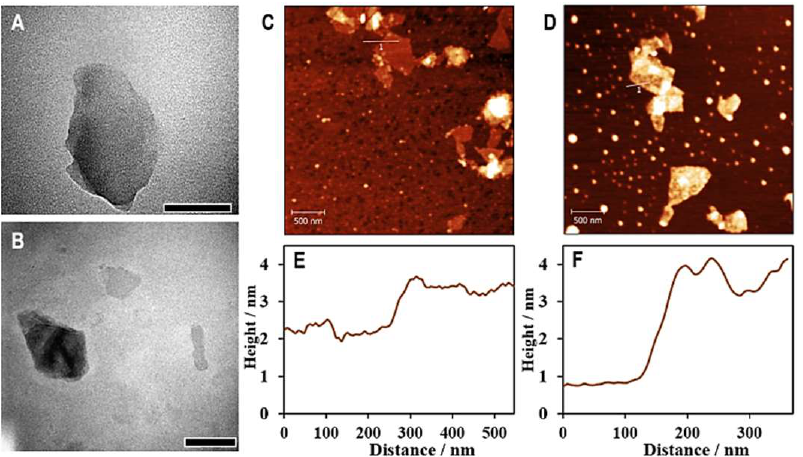
Figure 2. TEM and AFM analysis of GO and HGNs. TEM images of graphene oxide nanosheets ( A ) and hemin–graphene nanocomposites (HGNs) ( B ), scale bars are 500 nm long. AFM images of graphene oxide ( C ) and HGNs ( D ) show detailed surface topographies of the nanosheets before and after conjugation with hemin, respectively; cross-sectional analyses identified by the lines as graphs in AFM images shows the heights of GO ( E ) and HGNs ( F ).